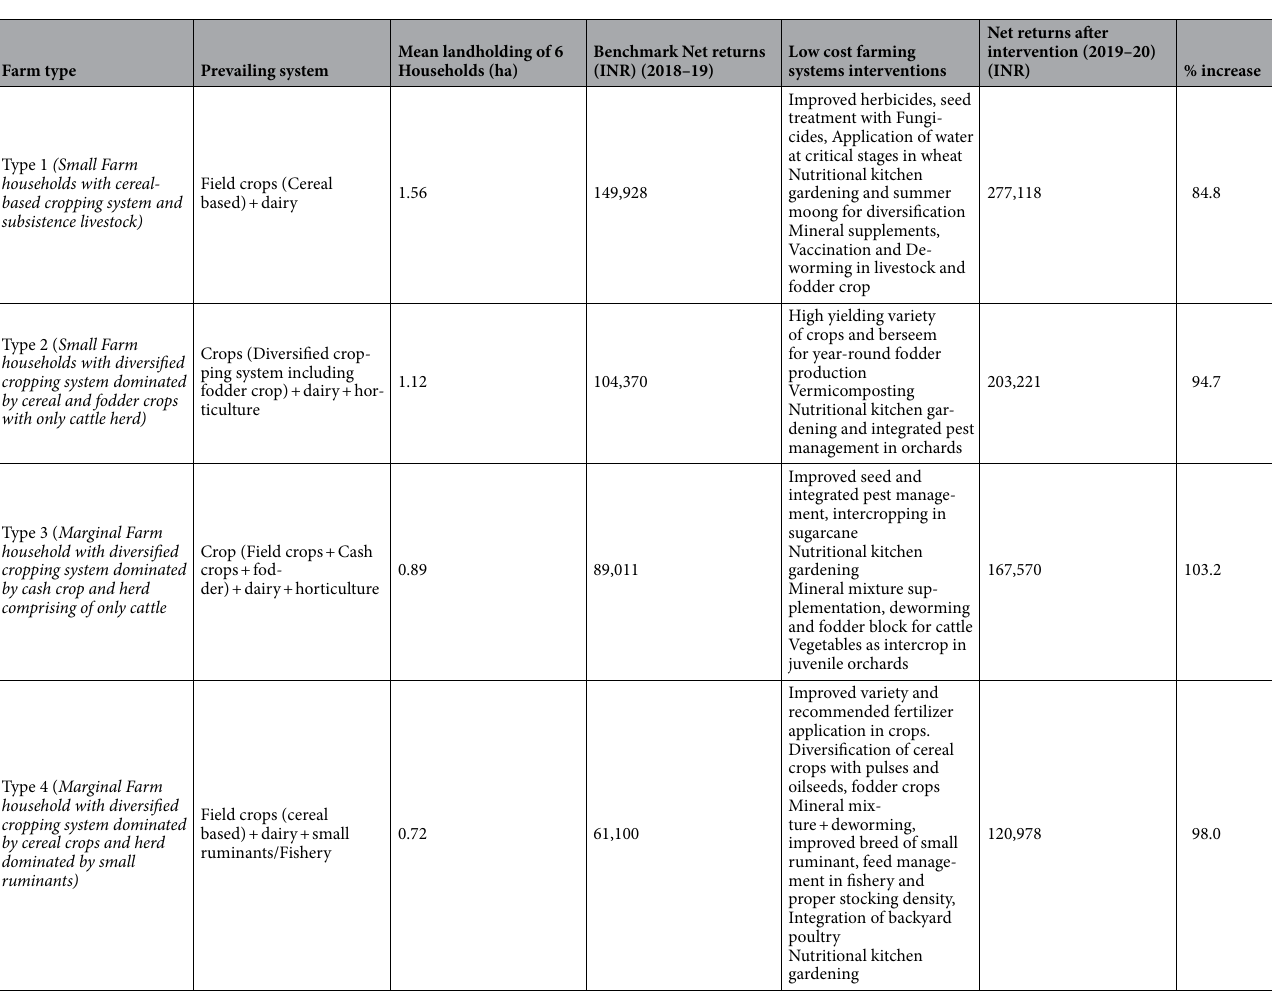
Table 4. Effect of Farm type wise low-cost intervention on net